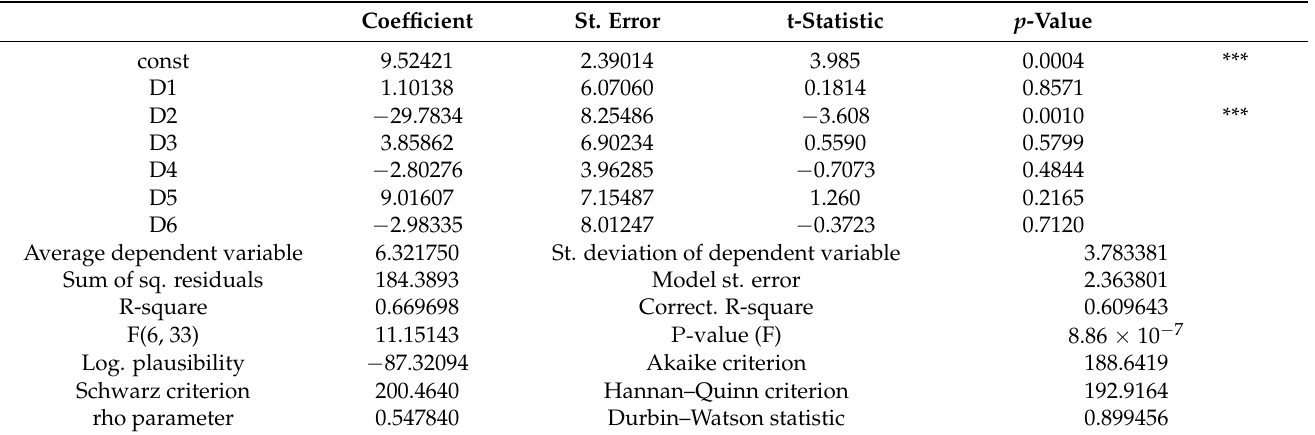
Table 13. Model frequency distribution statistics.